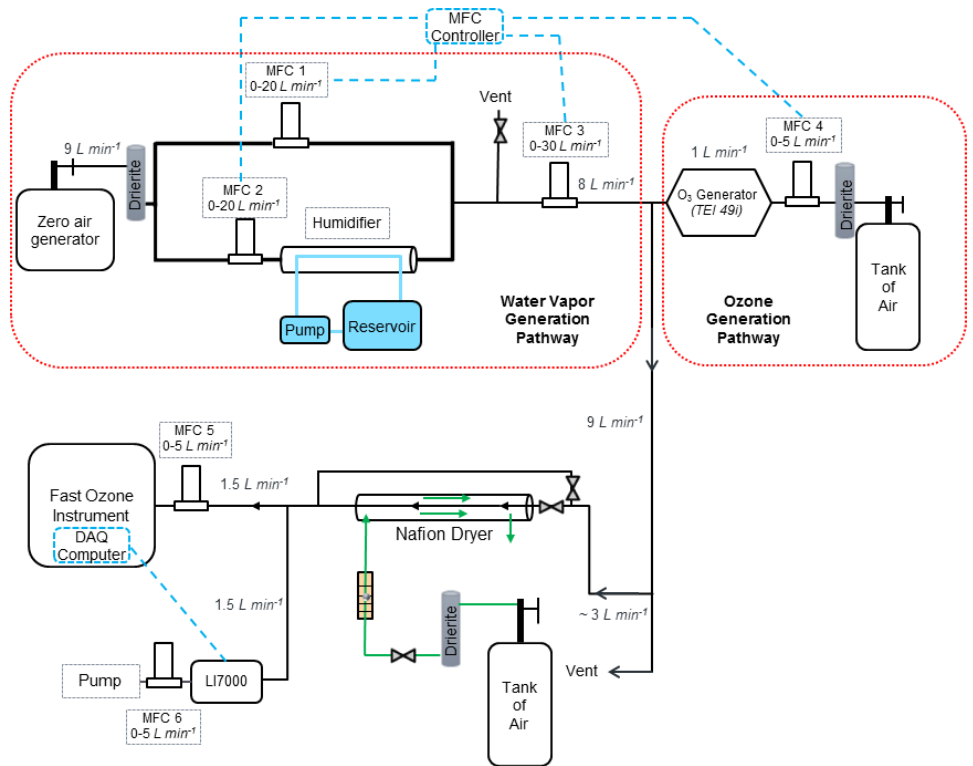
Fig. 2. Schematic of the laboratory setup. The red box in the upper left of the figure shows where the sample air was humidified. Ambient air was scrubbed through a zero-air generator and run through a drying agent. The flow was varied through mass flow controller (MFC) 1 to produce dry air and MFC 2 to produce humid air. The humidifier was a Nafion membrane containing liquid water in the inner tube and the sample flow through the outer shell. Excess flow was released through the vent with a flow restrictor. MFC 3 controlled the flow to 8Lmin − 1 . This air was mixed with ozone-enriched air from the TEI 49i ozone generator (red box in upper right of figure). Sample air was provided from a tank of dry breathing air. The flow through the ozone generator was controlled to 1Lmin − 1 . The Nafion drying system, FROI and LI-7000 are shown at the lower portion of the figure. Switching valves directed the flow through or around the Nafion dryer. MFCs 5 and 6 controlled the flow to the FROI and LI-7000 and were set at 1.5Lmin − 1 . All data were collected on the data acquisition computer housed in the